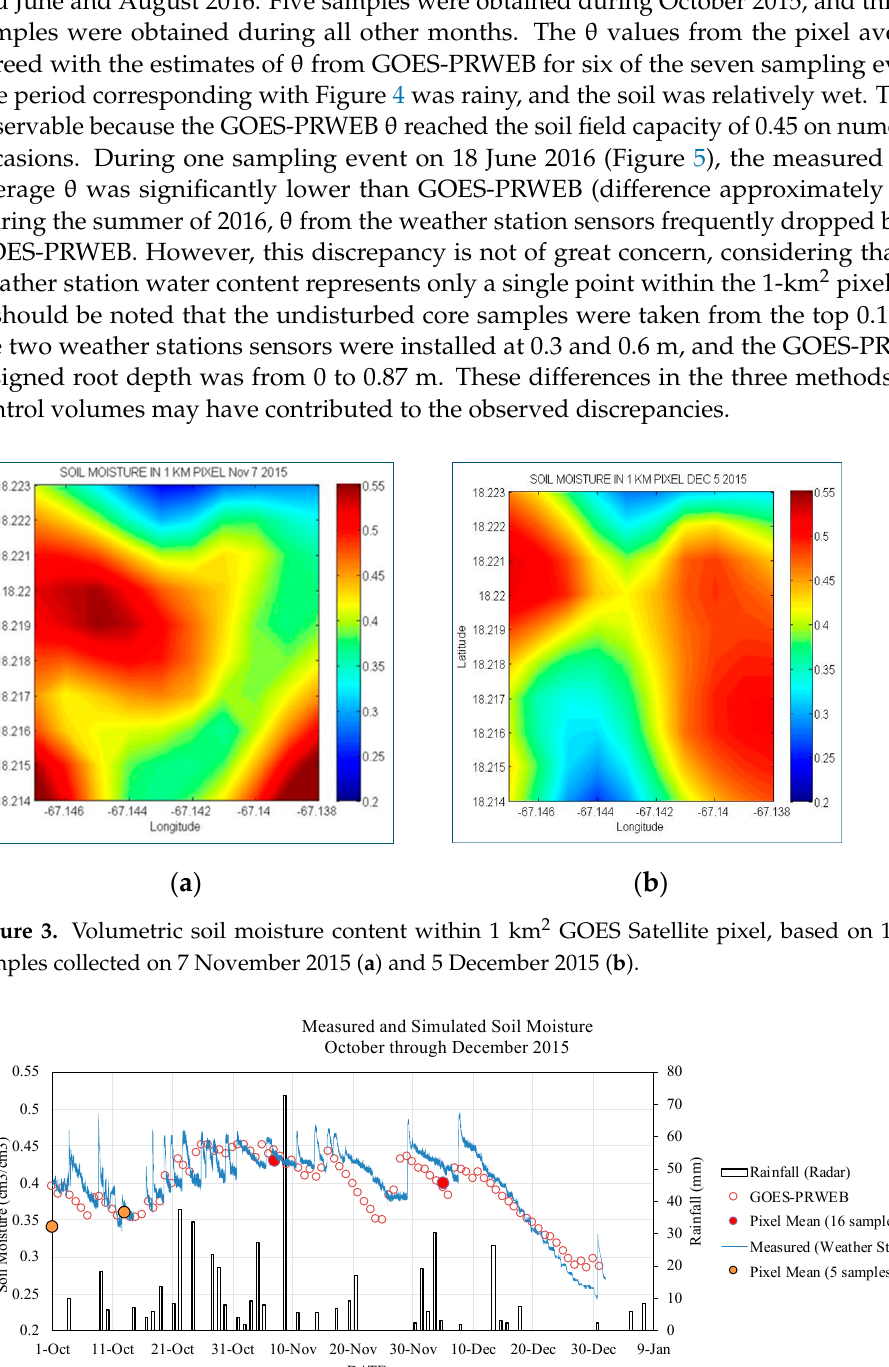
Rainfall (Radar) Rainfall (Radar) GOES-PRWEB GOES-PRWEB Pixel Mean (16 samples) Pixel Mean (16 samples) Measured (Weather Station) Measured (Weather Station) Pixel Mean (5 samples) Pixel Mean (5 samples)